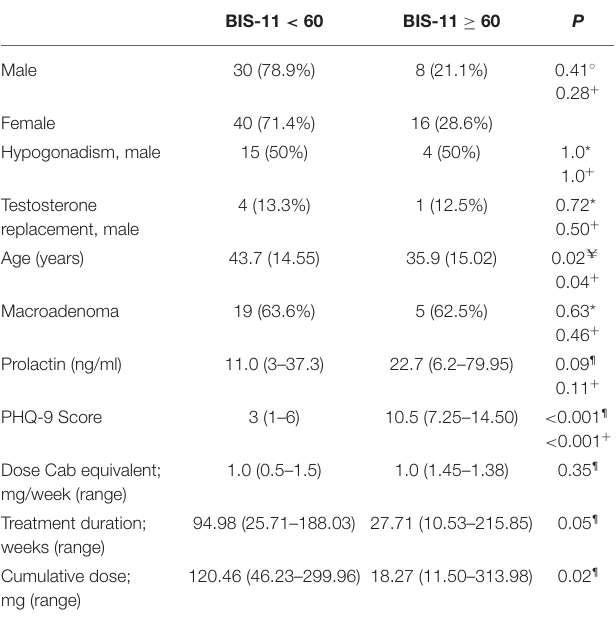
TABLE 2 | Association and correlation values for increased BIS-11